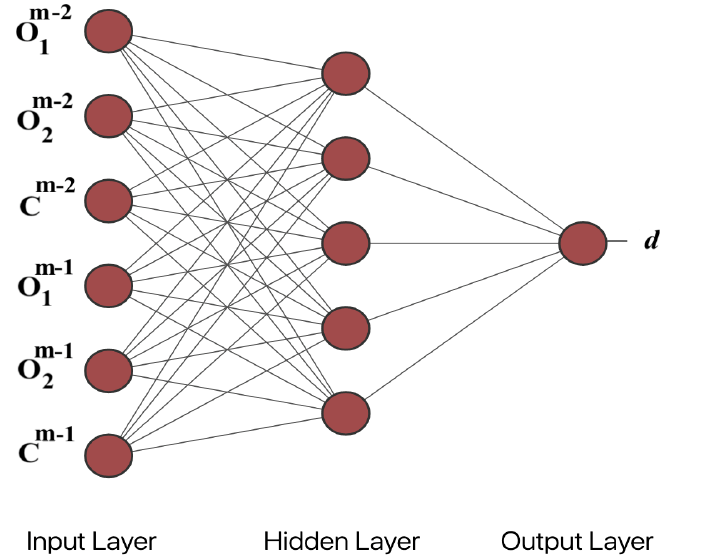
Figure 2. The NN architecture. See text for explanation of